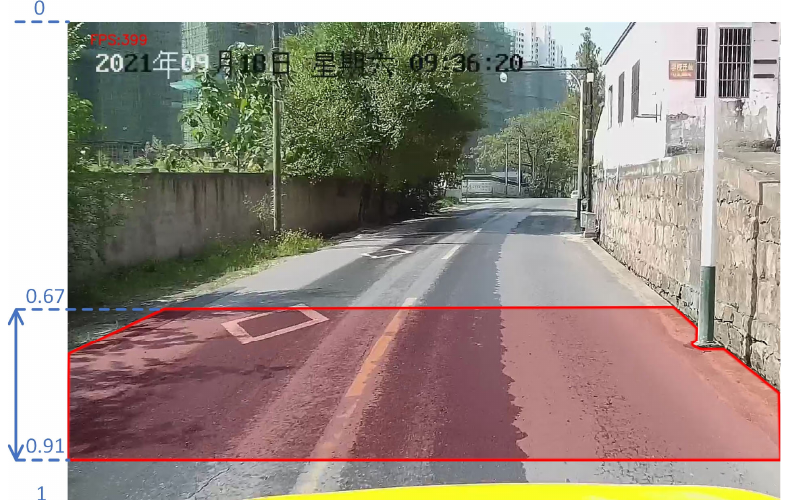
Figure 7. Example of pasting range of a manhole cover. The red area in the image is the pasting range. Each road segmentation model was retrained on the UAS dataset for 300 epochs, and